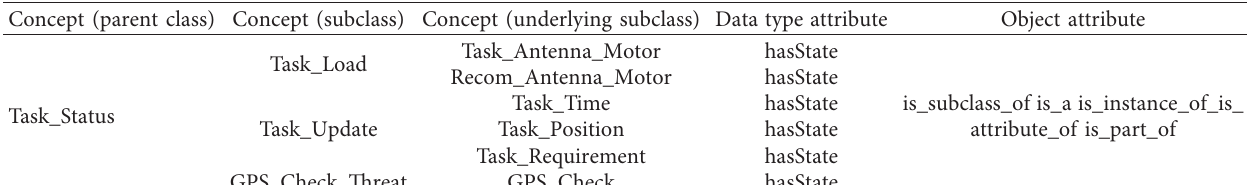
Table 4: Classes and attributes in the UUV task status application ontology.